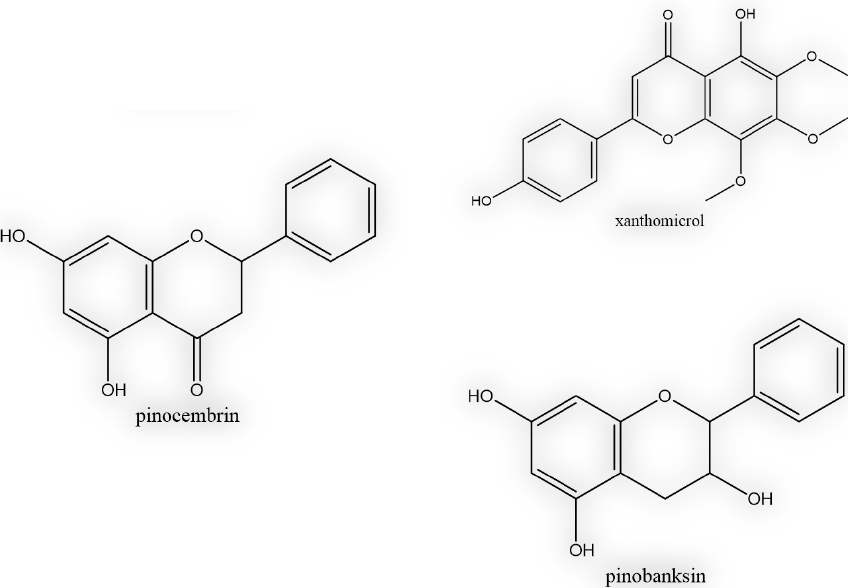
Figure 5. Chemical structure of the ligands (propolis active compounds). As shown in Table 3, the binding mode of etoposide was matched with the propolis with Arg 503 with a binding energy ( − 6.25) Kcal/mol as Asp479 and Arg503 are the